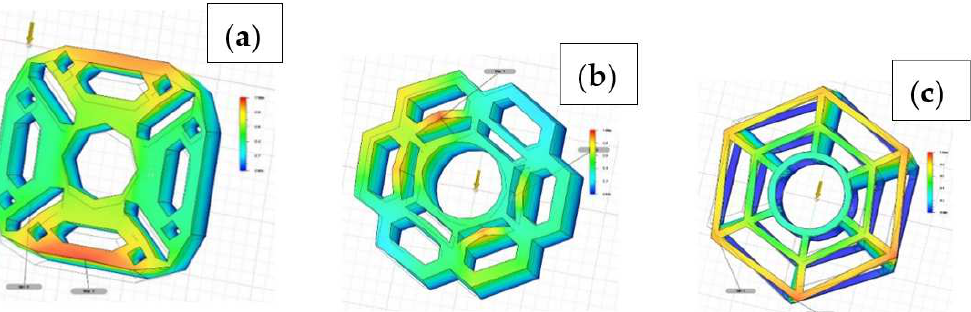
Figure 10. Parameters of the simulations.